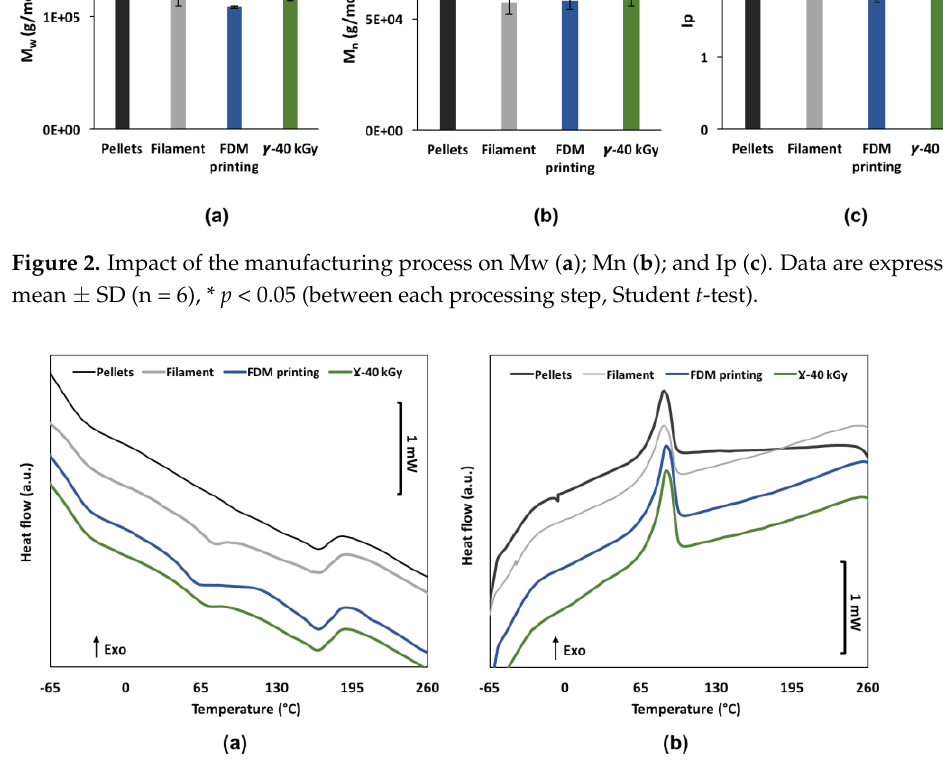
Figure 3. DSC traces from first heating run ( a ) and cooling run ( b ) for the raw pellets, extruded filament, FDM processed and sterilized samples. Table 2. Collected DSC data (n = 3) from first cycle (mean ± SD).